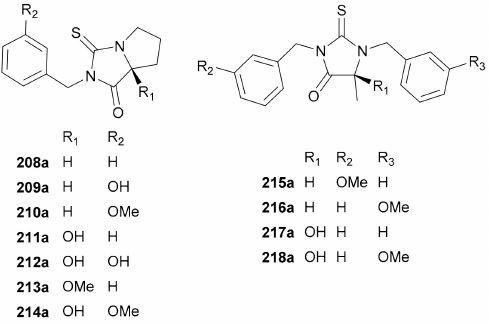
Figure 12. Structures of thiohydantoin alkaloids.